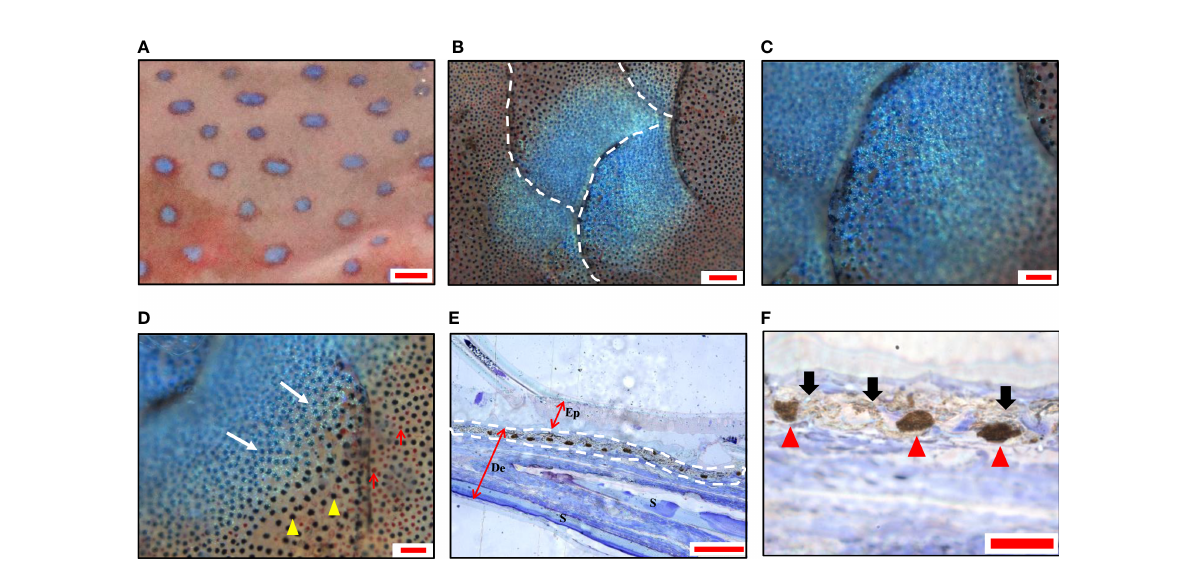
FIGURE 1 Morphology and chromatophores distribution of blue spots in leopard coral trout Plectropomus leopardus . (A) A magni fi ed image of the skin shows blue spots with irregular shapes. (B) A panoramic image shows blue spots distributed over multiple scales under a light microscope. (C) The center of the spot is dark blue, and (D) the surrounding blue becomes lighter. Melanophores (yellow arrowheads); Erythrophores (red arrows). (E) A representative image of semi-thin sections (toluidine blue staining), shows continuously aggregated melanophores in the dermis. The white dashed line indicates the position of chromatophores. Ep, epidermis; De, dermis; S, scale. (F) The magni fi cation of the partial image in (E) shows aggregated melanophores (red arrowhead) and iridophores (black arrow). Scale bars: 2 mm (A) ; 200 m m (B) ; 100 m m (C – E) ; 25 m m (F)